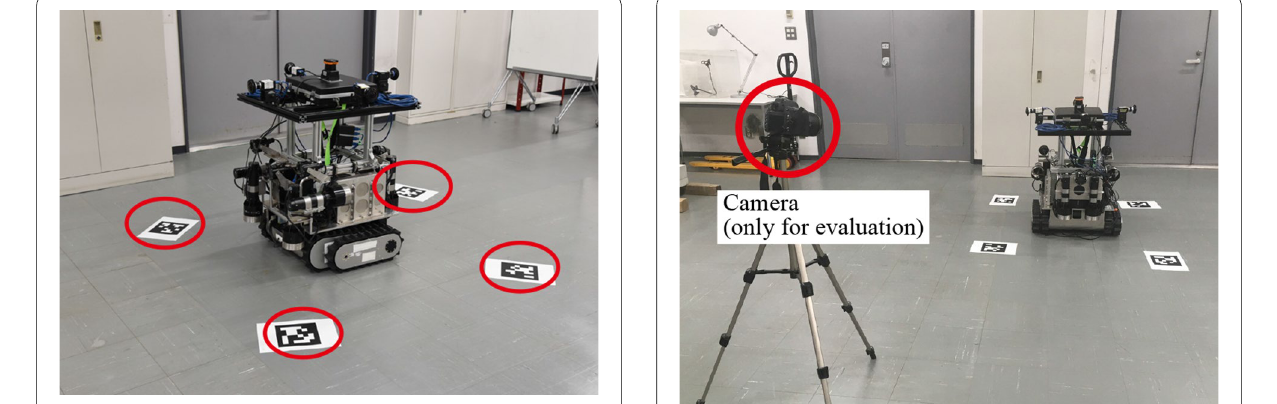
Fig. 9 Four AprilTags [16, 17] circled in red are placed on the floor for the calibration